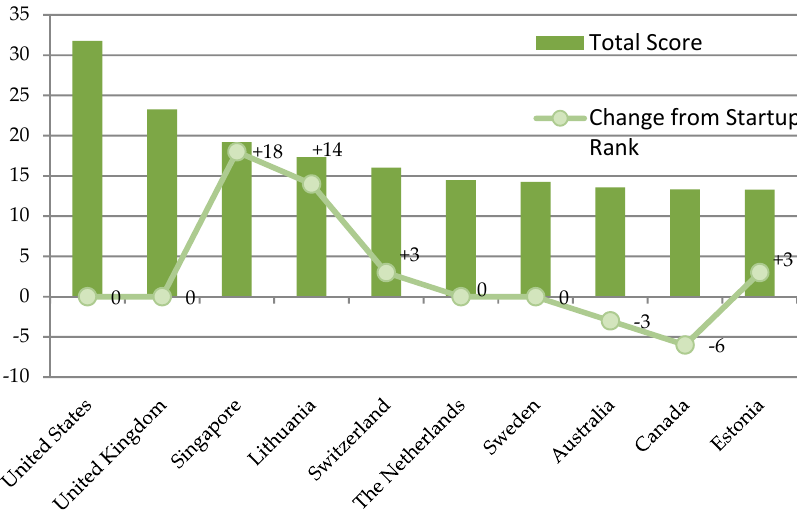
Figure 2. Global FinTech Ranking (Finde Able The Global Fintech Index 2020).